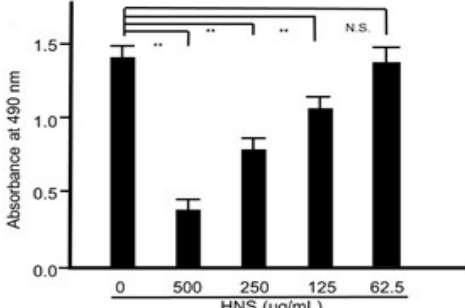
Figure 2. Suppressive effects of the HNS on the biofilm formation by S. mutans . S. mutans cells were treated with HNS for 48 h. The adherent bacteria were stained with safranin red and the biofilm formation was quantified by absorbance at 490 nm. Data represent the mean ± S.D. ( n = 6). **: p < 0.01 by Tukey’s multiple comparison tests. NS: not significant.